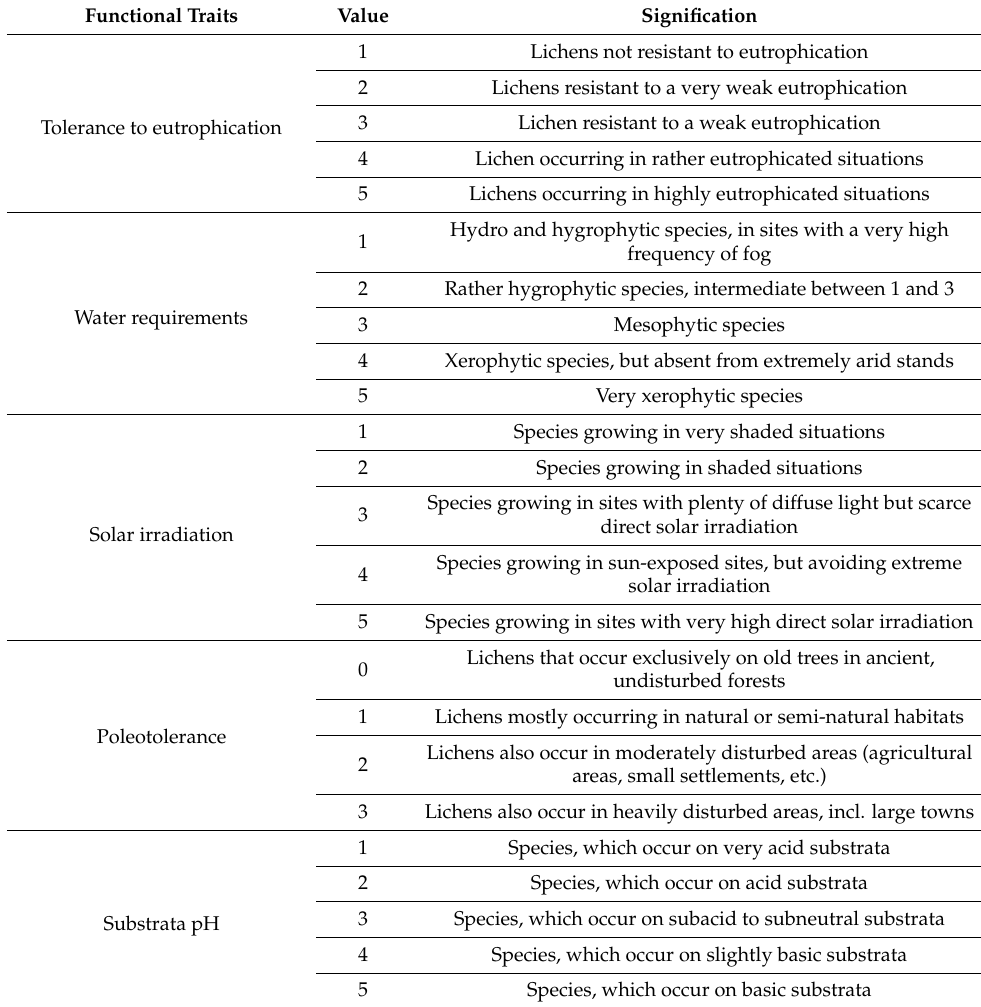
Table 3. Functional traits: Ecological requirement. Extracted from Ref.